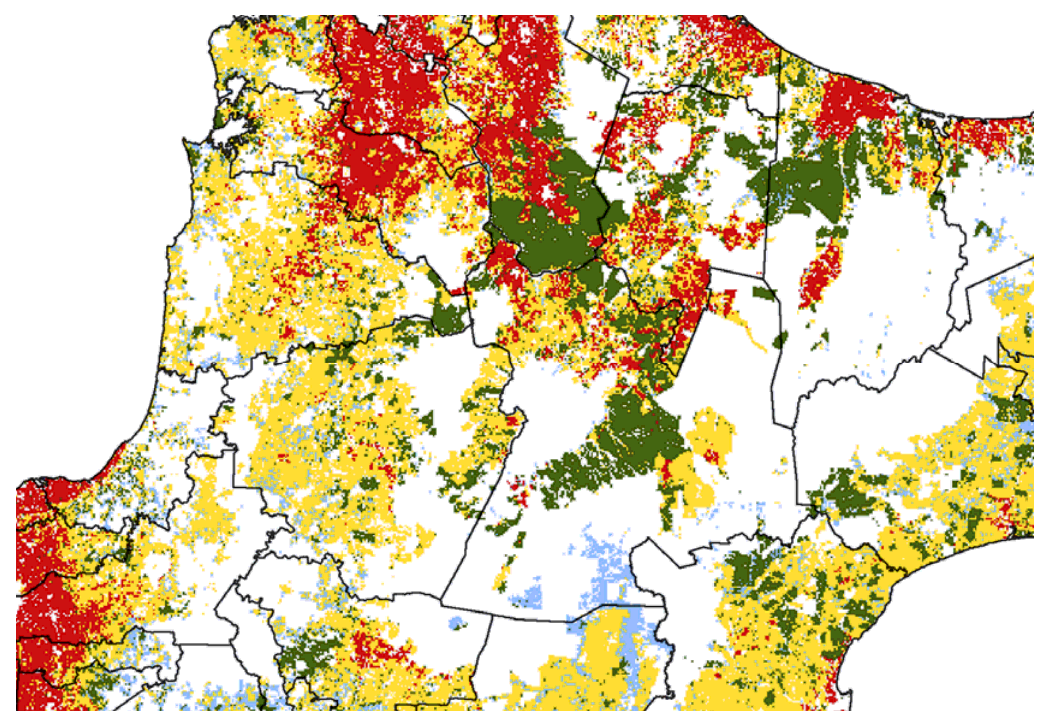
Figure 3. Baseline land use in 2030. The figure shows baseline land-use projections for central North Island in 2030. Dairy land is red, sheep-beef land is yellow, forestry land is green and scrub land is blue. White land is exogenous in